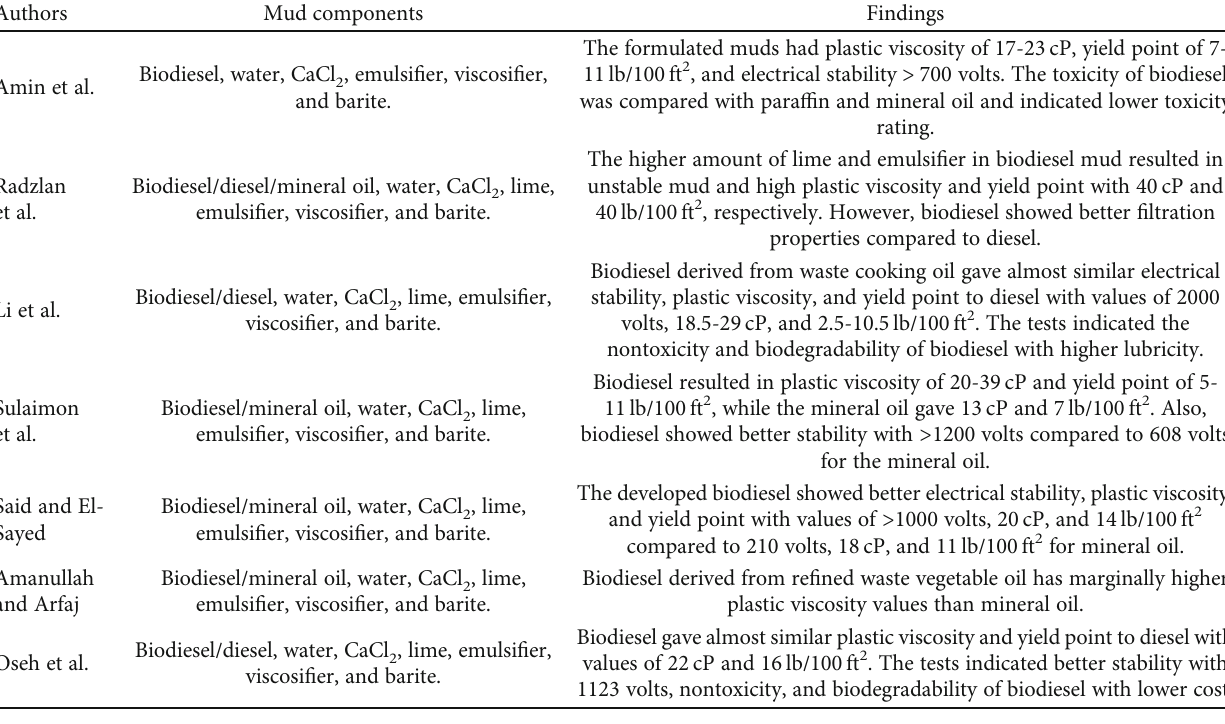
Table 3: Mud components and fi ndings of water in biodiesel invert emulsion mud